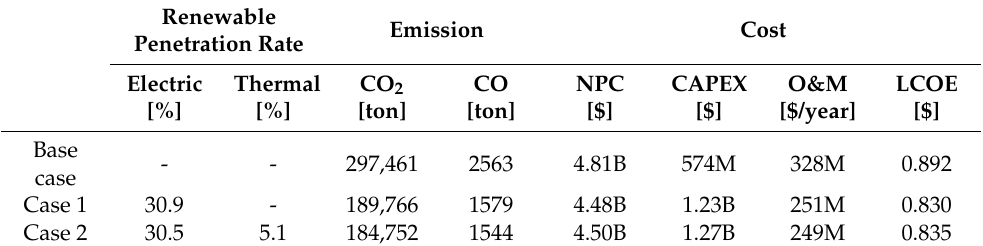
Table 3. Comparison of carbon emission and cost in each